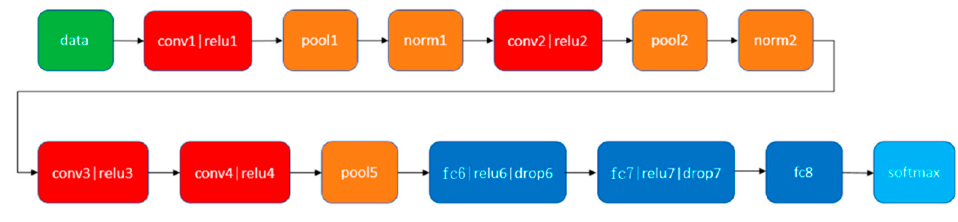
Figure 3. Identification network configuration [21].